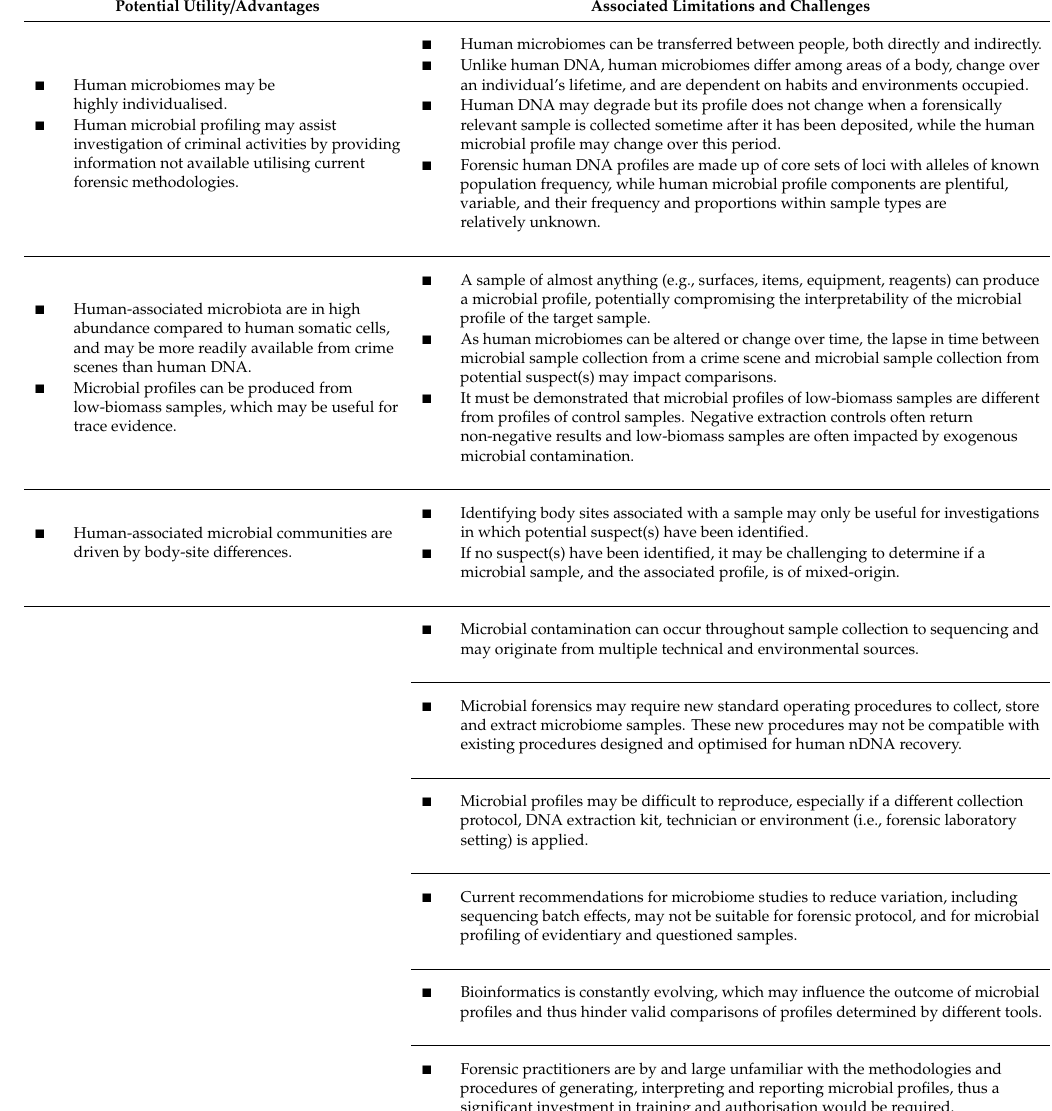
Forensic practitioners are by and large unfamiliar with the methodologies and procedures of generating, interpreting and reporting microbial profiles, thus a significant investment in training and authorisation would be